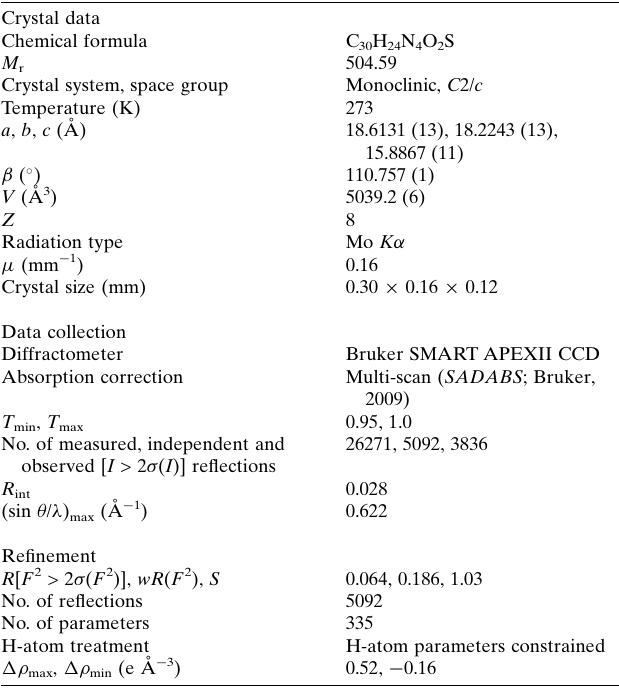
Crystal data Chemical